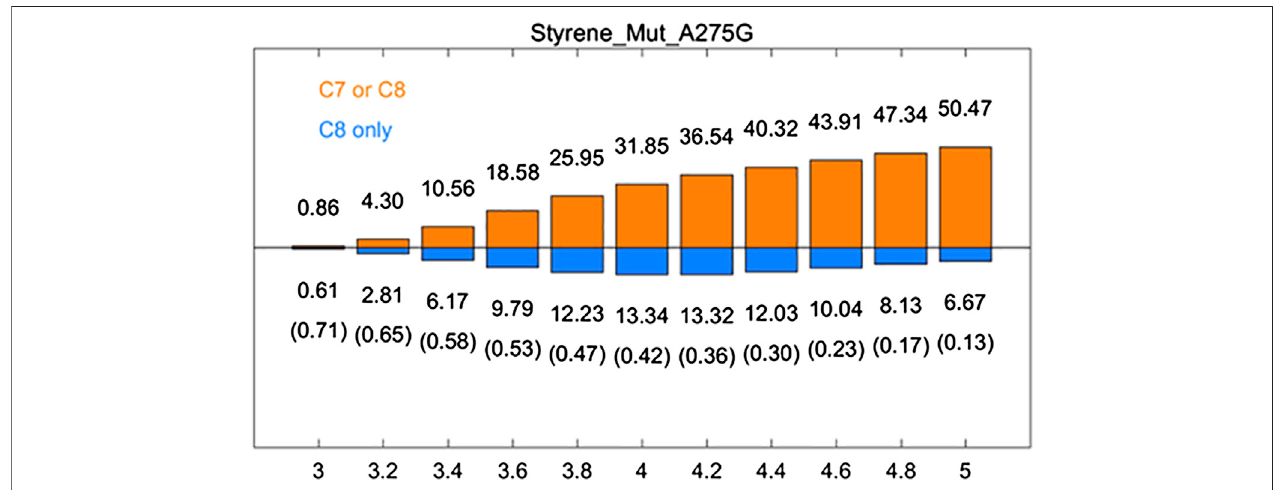
FIGURE6| Rateofp(C8only)/p(C7orC8)ofaMOxA275G.p(C8only)areshowninthebluebar,andp(C7orC8)areshownintheorangebar.Theratiosofp(C8 only)/p (C7 or C8) are also listed in the brackets. All results are the averages of the corresponding ten 30 ns aMD trajectories.